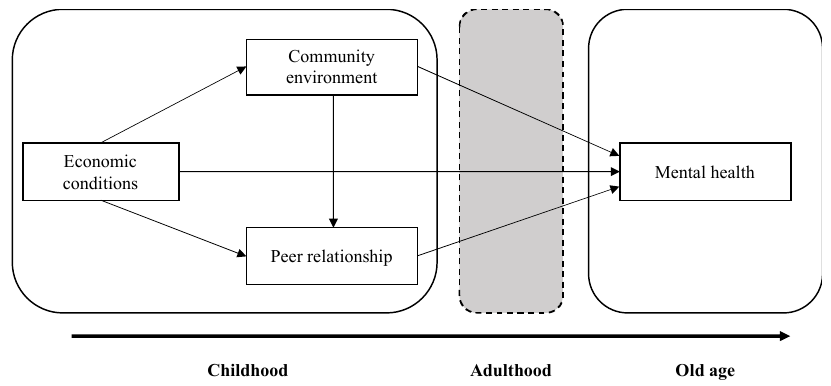
Figure 1. Path model of the relationships between earlier experience and later mental health.